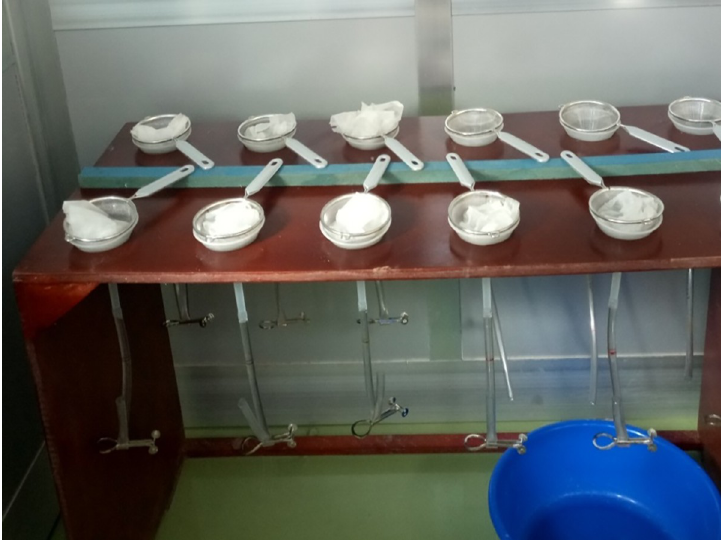
Fig 2. Funnel stand with Baermann apparatus for filtering of S . stercoralis larvae from stool